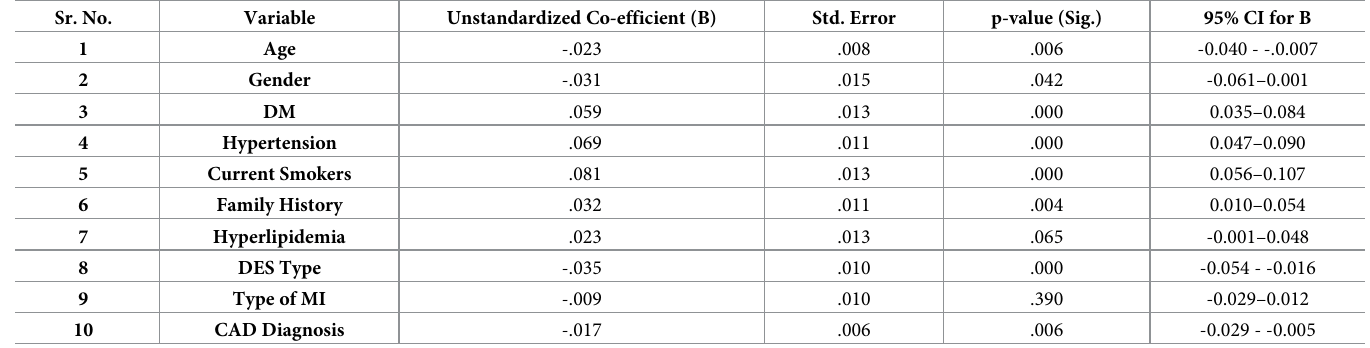
Table 3. Factors associated with utility scores (EQ-5D-5L). Sr. No.